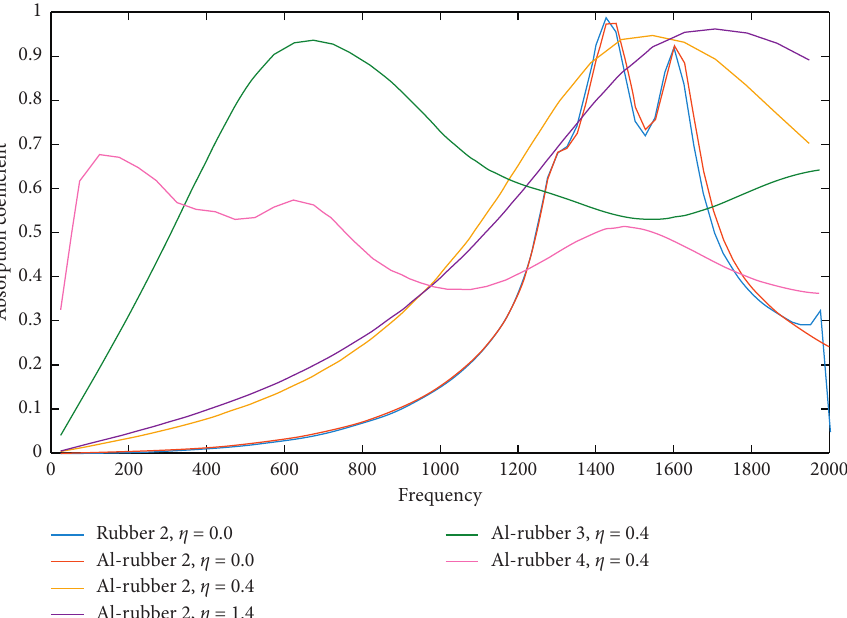
Figure 12: Absorption spectrum of different